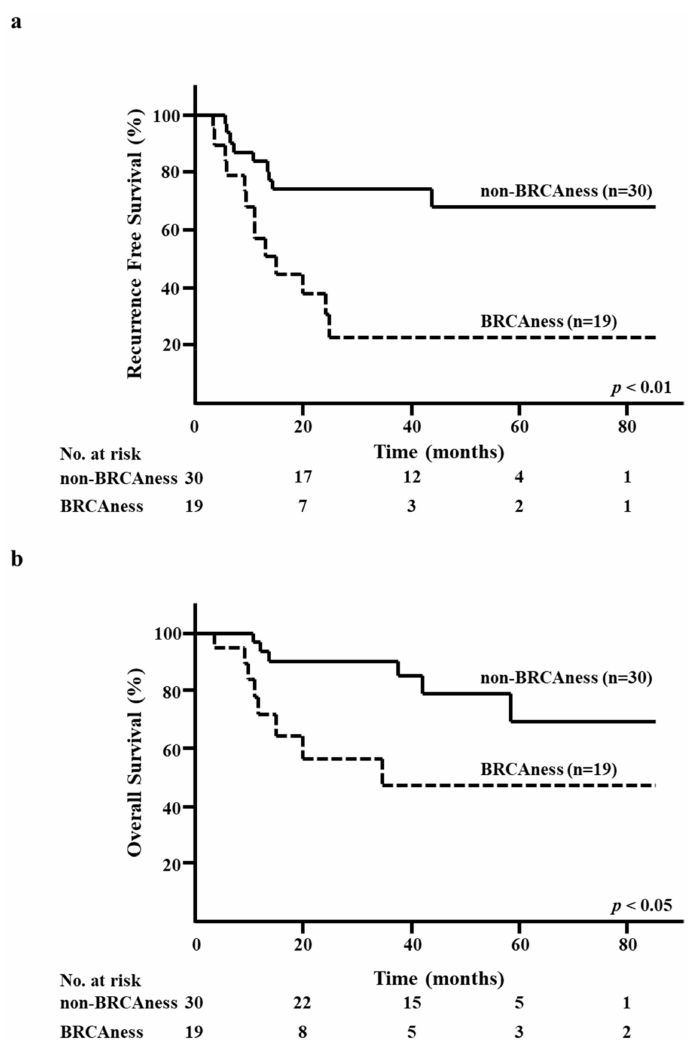
Figure 3. Kaplan–Meier analysis according to the BRCAness of surgical specimens after neoadjuvant chemotherapy. ( a ) Recurrence-free survival (RFS) in the BRCAness and non-BRCAness groups. ( b ) Overall survival (OS) in the BRCAness and non-BRCAness